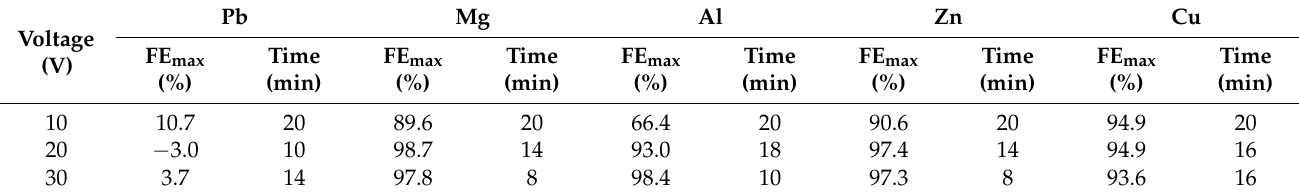
Table 1. Maximum FE (FE max ) values and their corresponding time during electrocoagulation.